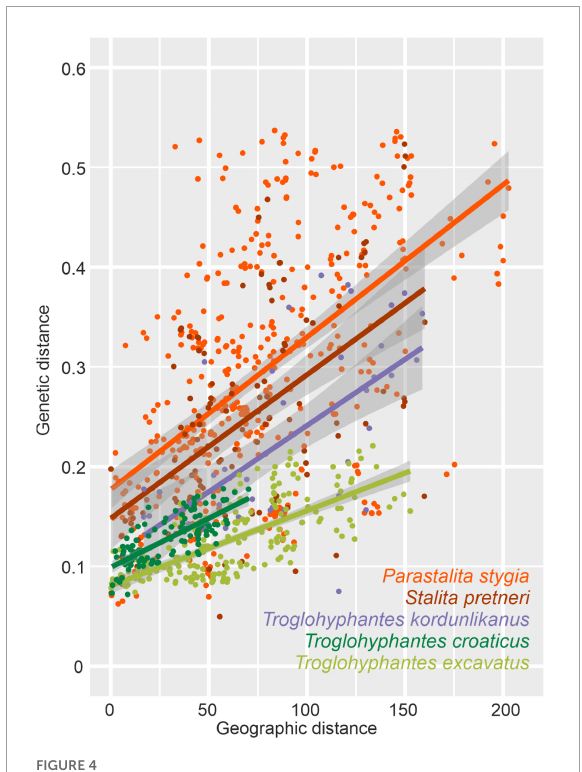
FIGURE4 Plot showing the overall relationship between pairwise Nei’s genetic and linear geographical distances for each of the five studied species. A linear model is represented for each species, with corresponding information, adjusted R -squared ( R 2 ) and linear equations indicated in Table 3 .